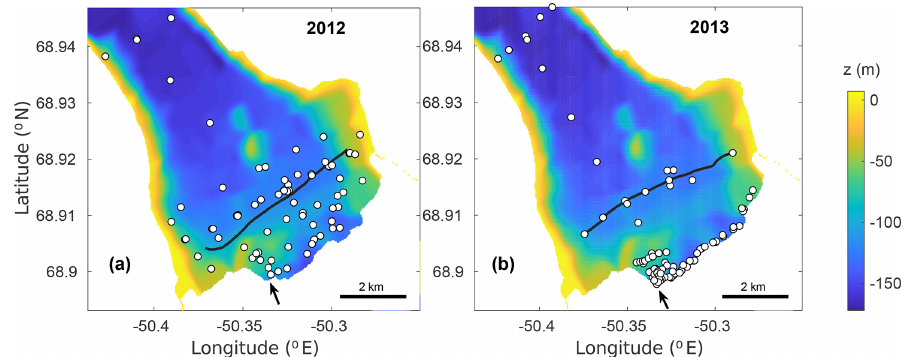
Figure 2. Bathymetric map of the Saqqarleq Fjord area (dark rectangle in Fig. 1). CTD cast locations (white dots) and ADCP transects (dark lines) in 2012 (a) and 2013 (b) . The location of the main plume is indicated by the black arrow.